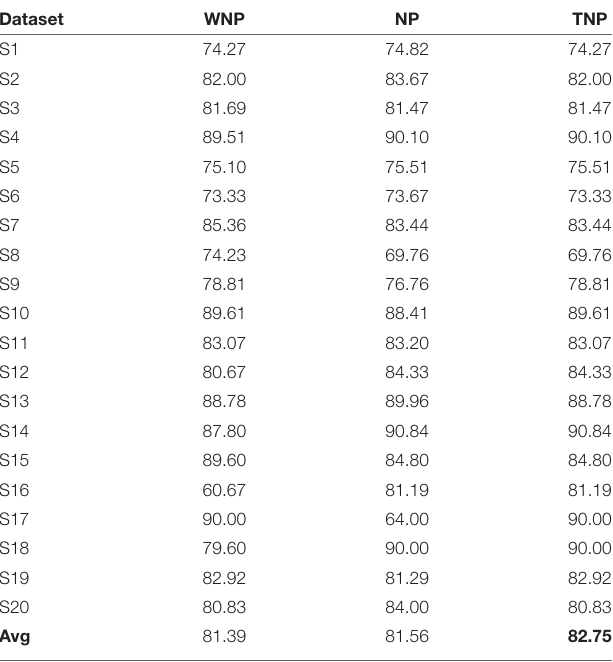
TABLE 5 | Comparison of classification performance of spike-representation (from LIF) of ERN datasets with xGboost under different prioritization conditions such as: without node prioritization (WNP), node prioritization (NP), and threshold-based node prioritization (TNP).